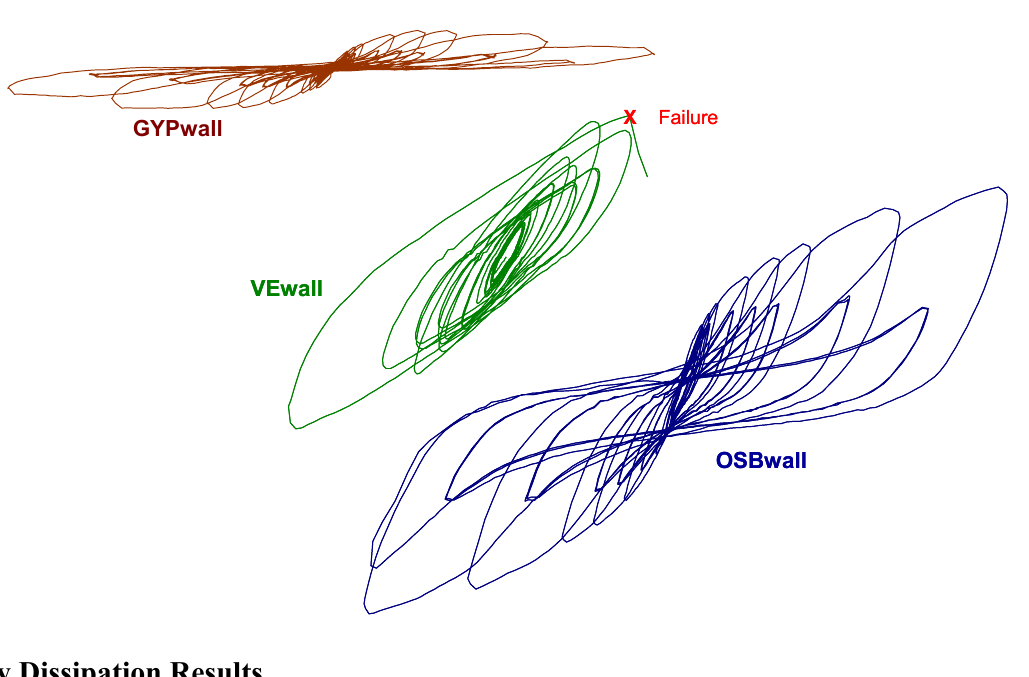
Figure 8. Representative hystereses plotted to the same